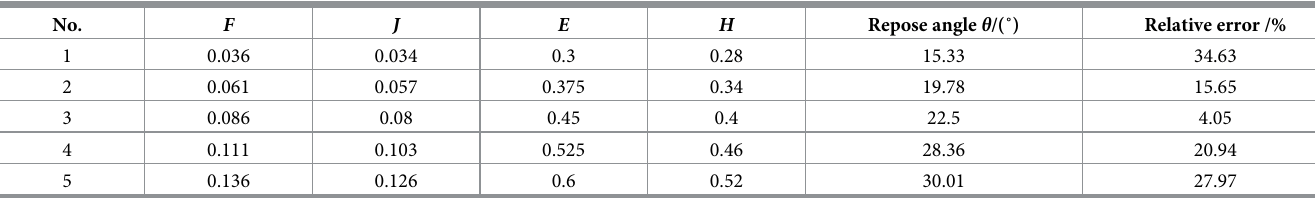
Table 5. Design and results of climbing test.